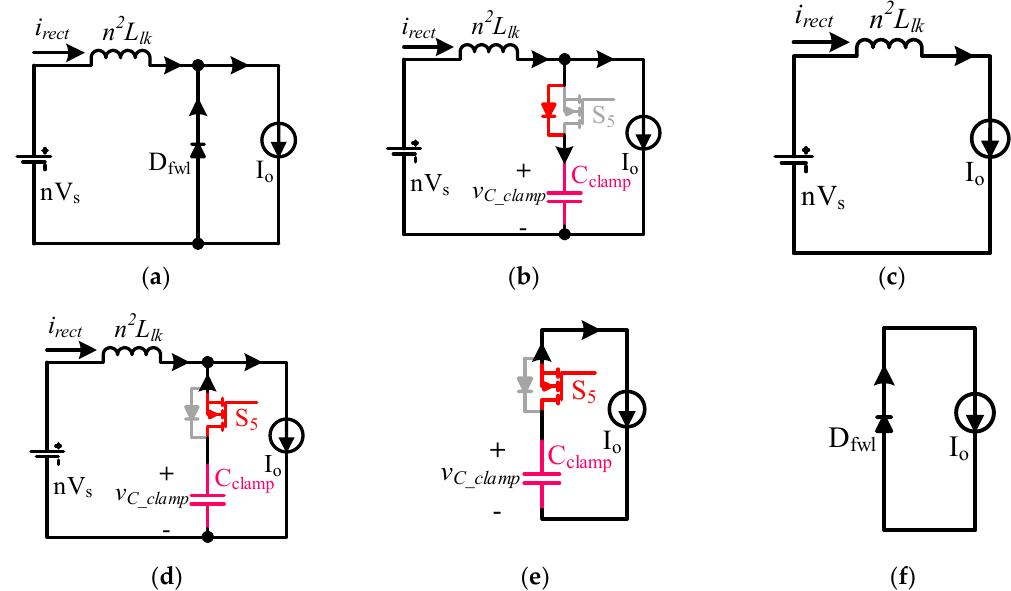
Figure A1. Simplified equivalent circuit model of the proposed converter. ( a ) Mode 2: inductor charging stage; ( b ) Mode 3: capacitor resonant charging stage; ( c ) Mode 4: inductor constant current stage; ( d ) Mode 5: capacitor resonant discharging stage; ( e ) Mode 6 (Model 8): capacitor linear discharging stage; ( f ) Mode 9: freewheeling stage.